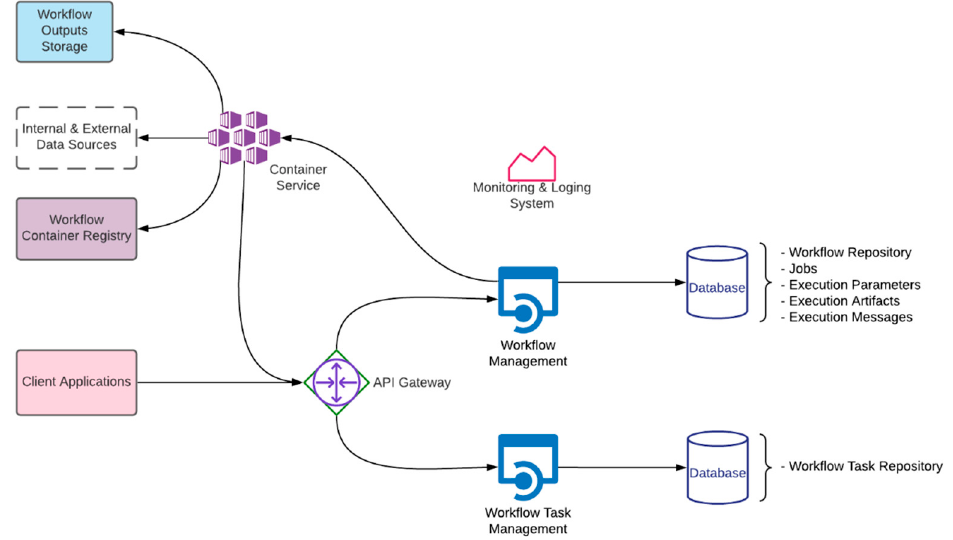
Figure 6. The workflow system and its components.